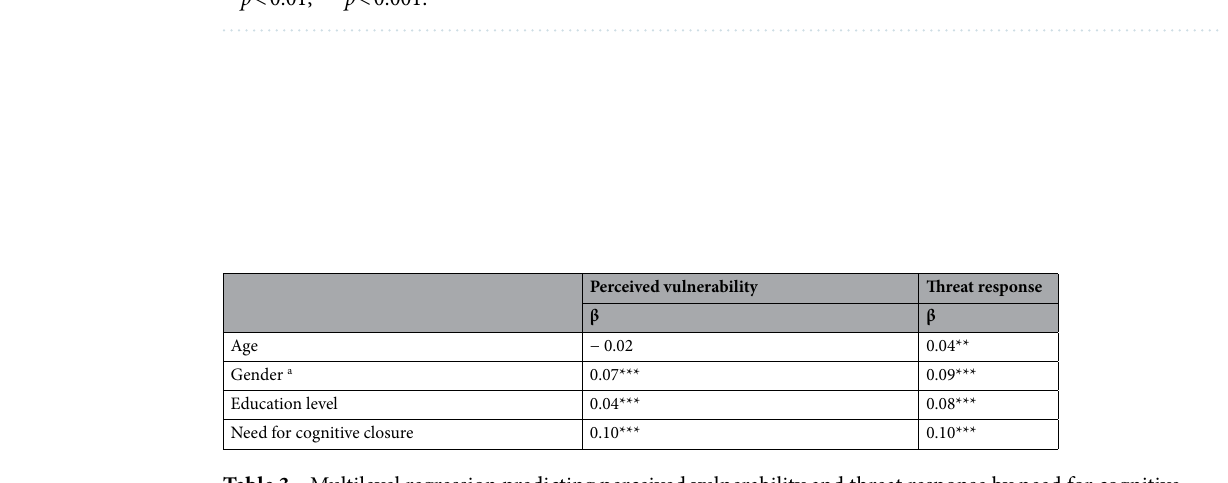
Table 2. Correlations among coronavirus anxiety, mental well-being, and society-level indicators. * p < 0.05, ** p < 0.01, *** p < 0.001.